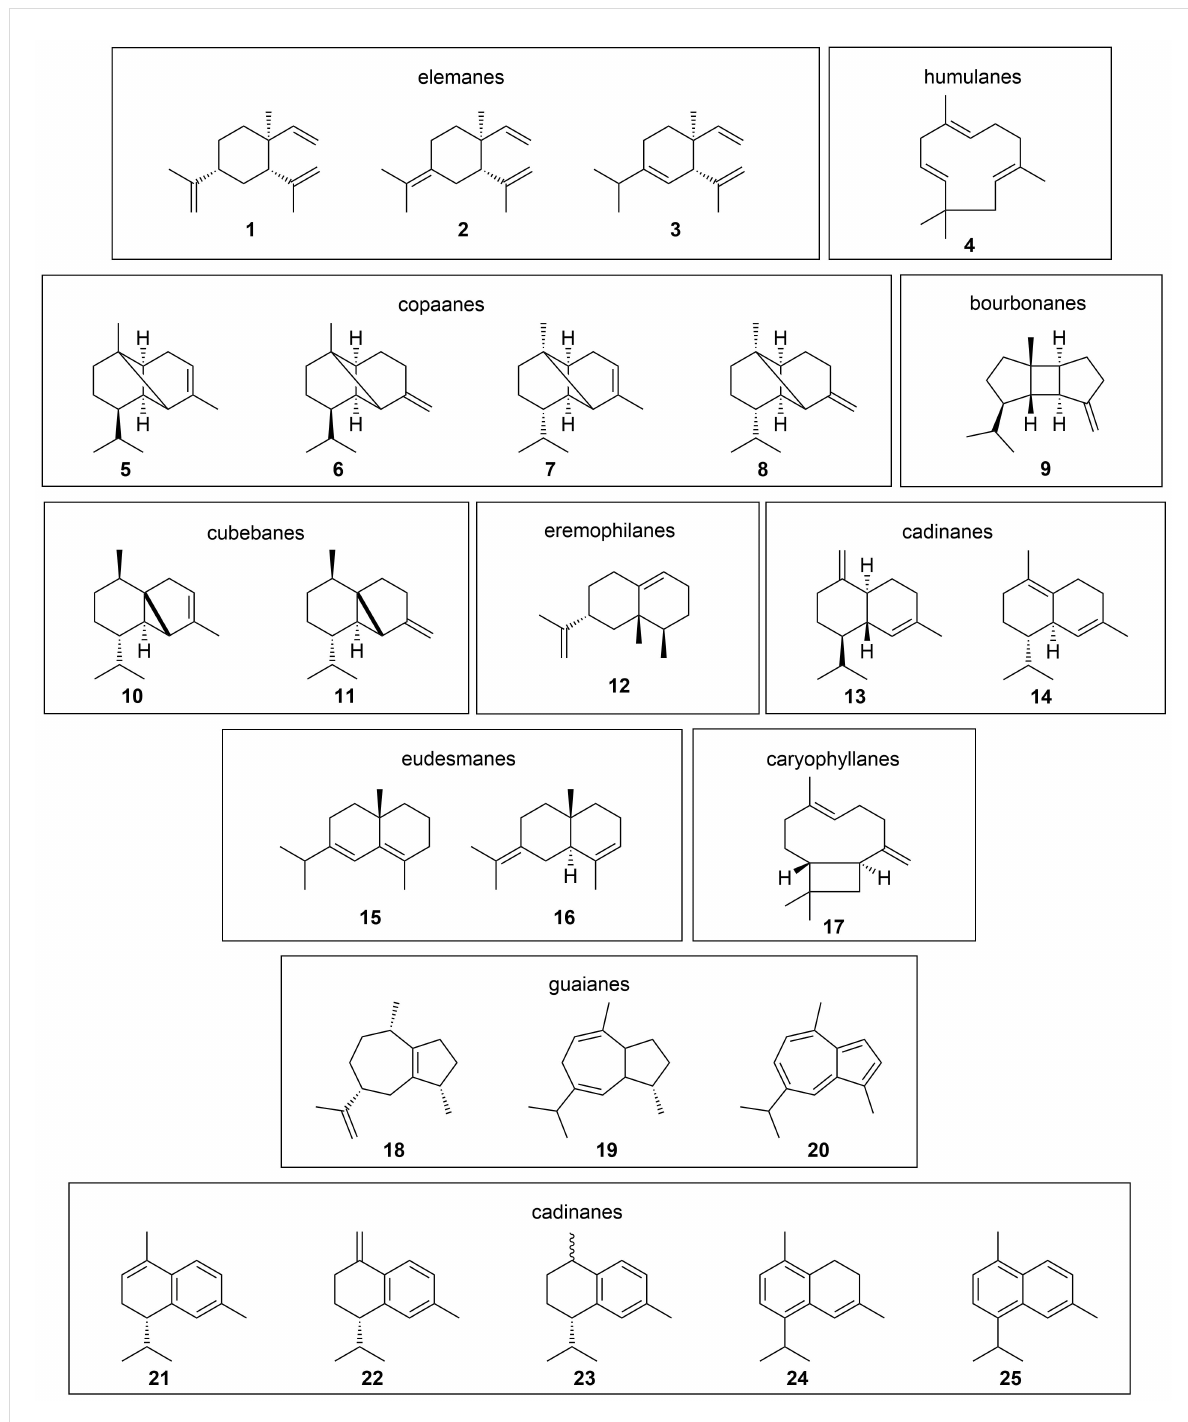
Figure 2: Sesquiterpene hydrocarbons found in the headspace of Lemberger ( Vitis vinifera subsp. vinifera , clone 1Gm, exocarp). 1–4 , monocyclic sesquiterpenes; 5–11 , tricyclic sesquiterpenes; 12–25 , bicyclic sesquiterpenes; 20–25 , aromatic sesquiterpenes. The identified compounds are grouped according to the type of sesquiterpene